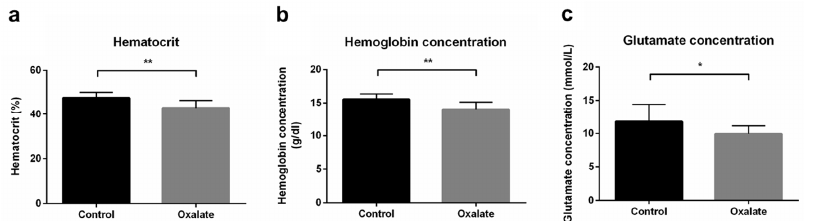
Figure 4. Impact of the 3-week OXA diet on systemic parameters: ( a ) hematocrit (%); ( b ) hemoglobin concentration (g/dL); ( c ) glutamate concentration (mmol/L). Results are expressed as mean ± SD. * p ≤ 0.05; ** p ≤ 0.01. Control n = 6, oxalate n = 18. Table 1. Blood parameter analysis after 3 weeks of the OXA diet (results are expressed as mean ± SD. Control n = 6, oxa- late n = 18).